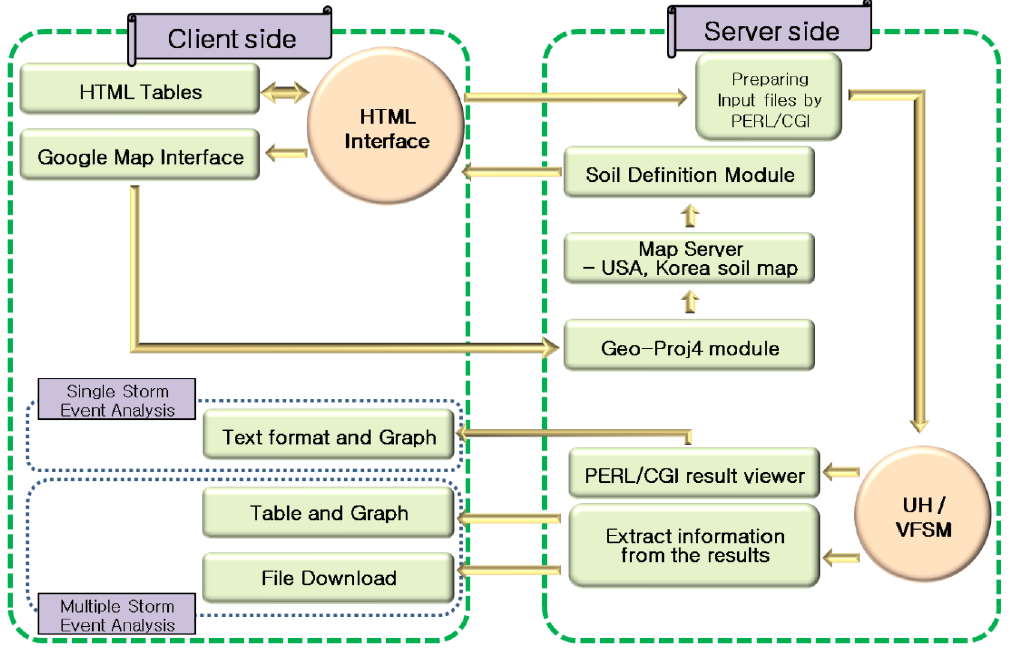
Figure 2. Overview of Web GIS-based VFSMOD